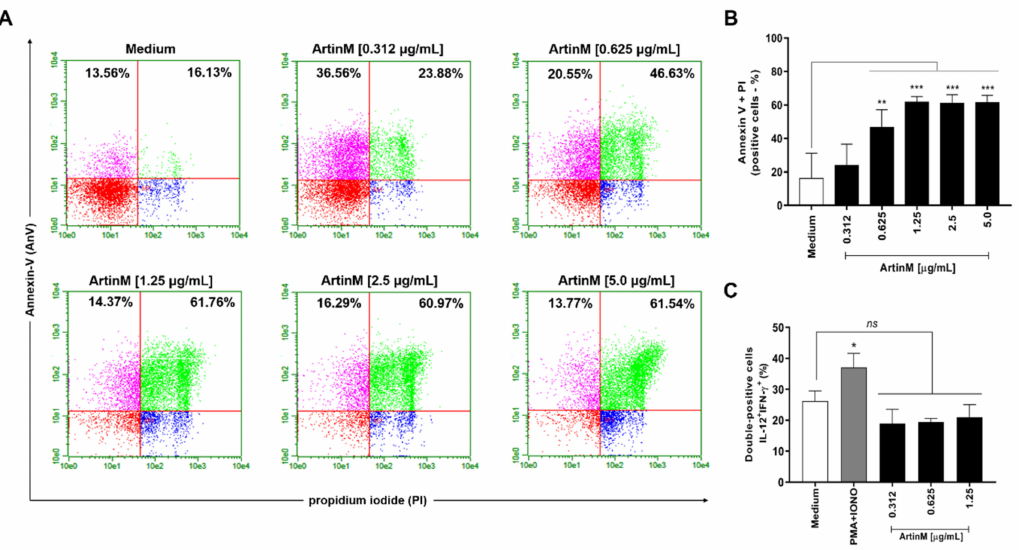
Figure 2. ArtinM increases the frequency of annexin V- and PI-positive B cells. B cells purified from a suspension of C57BL/6 mice spleen cells were seeded in 96-well microplates (5 × 10 5 cells/well) and incubated for 24 h with ArtinM at several concentrations. Medium alone was used as a negative control (Medium). ( A , B ) B cells were labeled with annexin V FITC and propidium iodide (PI) to determine the frequency of apoptotic cells (annexin V + PI) by flow cytometry. ( C ) The frequency of IL-12+/IFN- γ + double-positive cells was also determined by flow cytometry. A mixture of phorbol- 12-myristate-13-acetate (PMA; 50 ng/mL) plus Ionomycin (IONO; 1 µ M) was used as a positive control. Results are expressed as mean ± standard error of the mean (SEM), and three independent assays were performed. Significant differences compared to the medium are shown by *, p < 0.05; **, p < 0.01; and ***, p < 0.001. ns: not